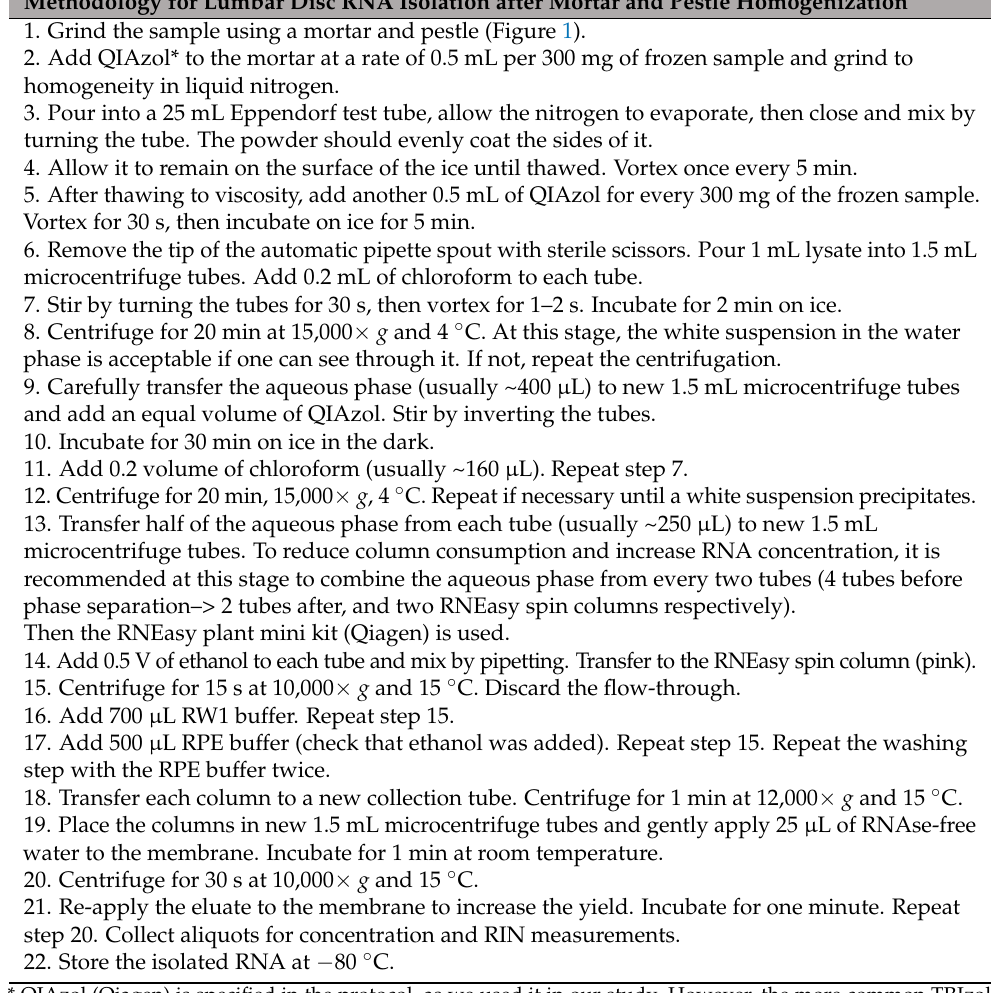
Table 1. The full protocol for RNA isolation. Methodology for Lumbar Disc RNA Isolation after Mortar and Pestle